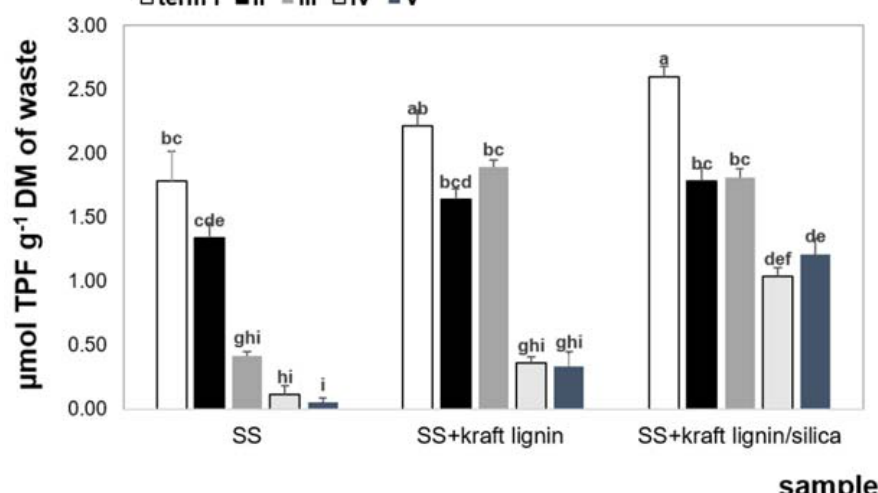
Figure 12. Changes in the dehydrogenase activity (DHA) in the digested samples. Explanation: a–i—di ff erent letters denote significant di ff erences at p = 0.05 ( significance level ). Means followed by the same letters do not di ff er significantly at p =